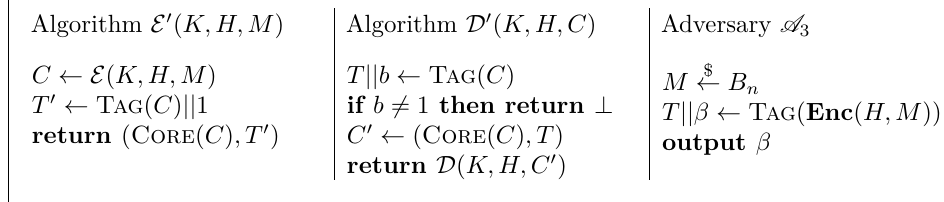
Figure 8: Definitions of Π 0 (left and middle) and adversary A 3 (right) for the proof of Proposition